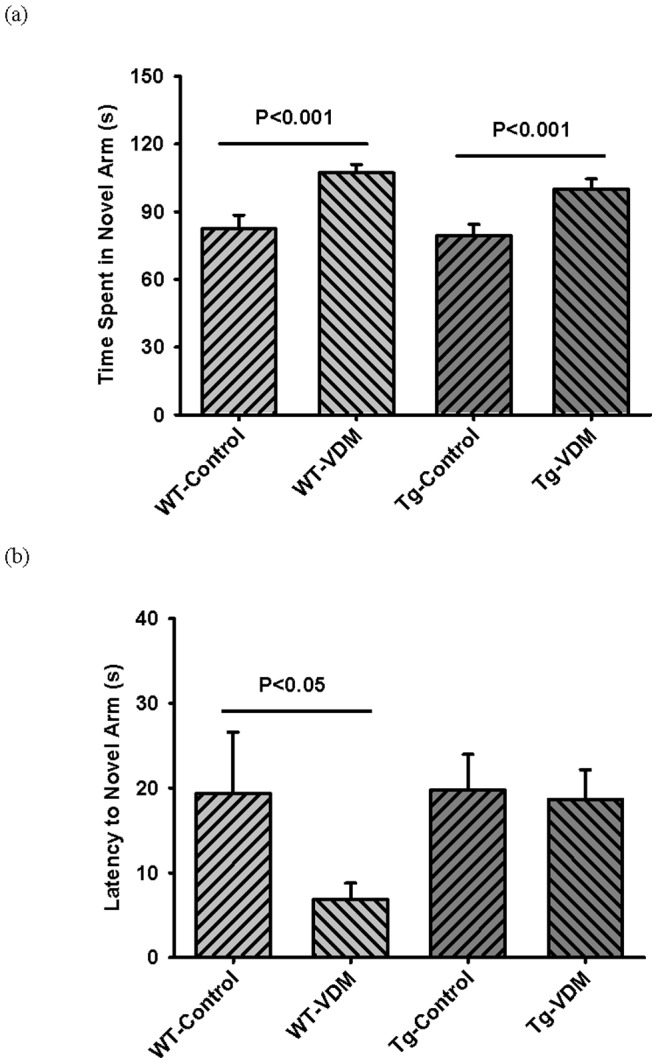
Dietary effects on Y maze probe trial at 9 months.Results shown are (a) time spent in novel arm and (b) latency to novel arm. Results represent the average for the group with standard error. For time in novel arm measure, WT-VDM stayed significantly longer than WT-control group by Kruskal-Wallis One Way ANOVA on Ranks (H = 23.731 with 3 degrees of freedom, P<0.001) whereas WT-controls spent similar time in all arms. Likewise, Tg-VDM group stayed significantly longer than Tg-control group by Kruskal-Wallis One Way ANOVA on Ranks (H = 21.324 with 3 degrees of freedom, P<0.001). WT-control and Tg-control groups spent similar times in all arms. For latency to novel arm measure, WT–VDM group showed improved learning by Mann-Whitney Rank Sum Test (U Statistic = 21.000, P<0.05).